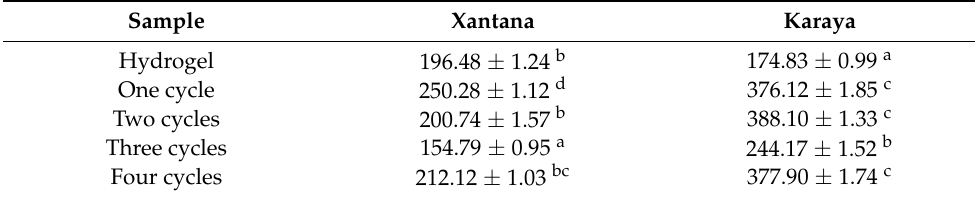
Table 2. Activation energies (kJ/mol) of the hydro- and cryogel